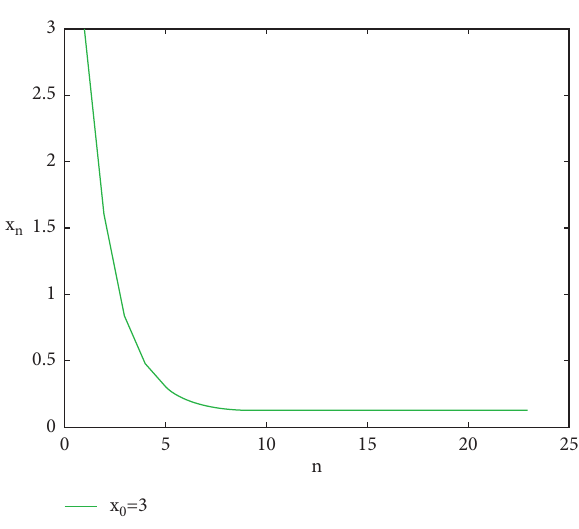
Figure 3: Case 3: for the initial value x